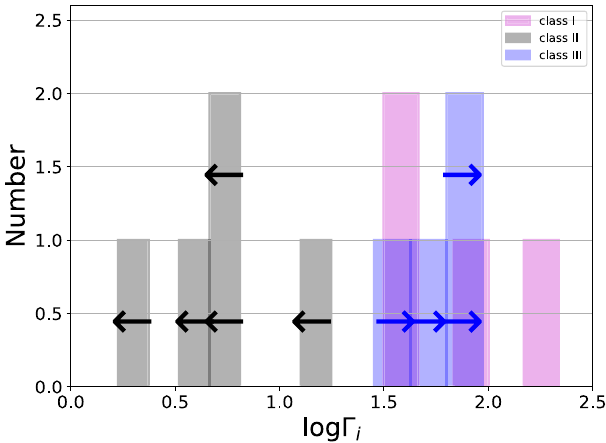
Fig.5|HistogramoftheinitialjetLorentzfactorsforthe13GRBsinoursample. These values are obtained by assuming that the fraction of energy in the magnetic fi eld is ϵ B =10 − 3 . The purple bars represent values deduced directly from the data (class I), the black bars are upper limits (class II) and the blue bars are lower limits (class III). Upper and lower limits are also marked by arrows. The average value of the initial GRBjetLorentzfactoris 〈 Γ i 〉 ≈ 51 (median is 32),although the rangespan isbetween1.7 ≲ Γ i ≤ 218(seeTable3).WepointoutthatGRB080607whichhasthe highestvalueof Γ i hasalargegapinitsX-rayLCbetweentheplateauandself-similar phases. Furthermore, GRB 171205A which has the lowest value of Γ i is associated with SN 2017iuk, therefore, both the optical plateau and self-similar slopes of this burst are effected by the SN bump (see, Supplementary Method 1b, Optical data and fi ttingprocessforfurtherdiscussion).Thesourcedatatoreproducethis fi gure are provided as a Source Data fi le.